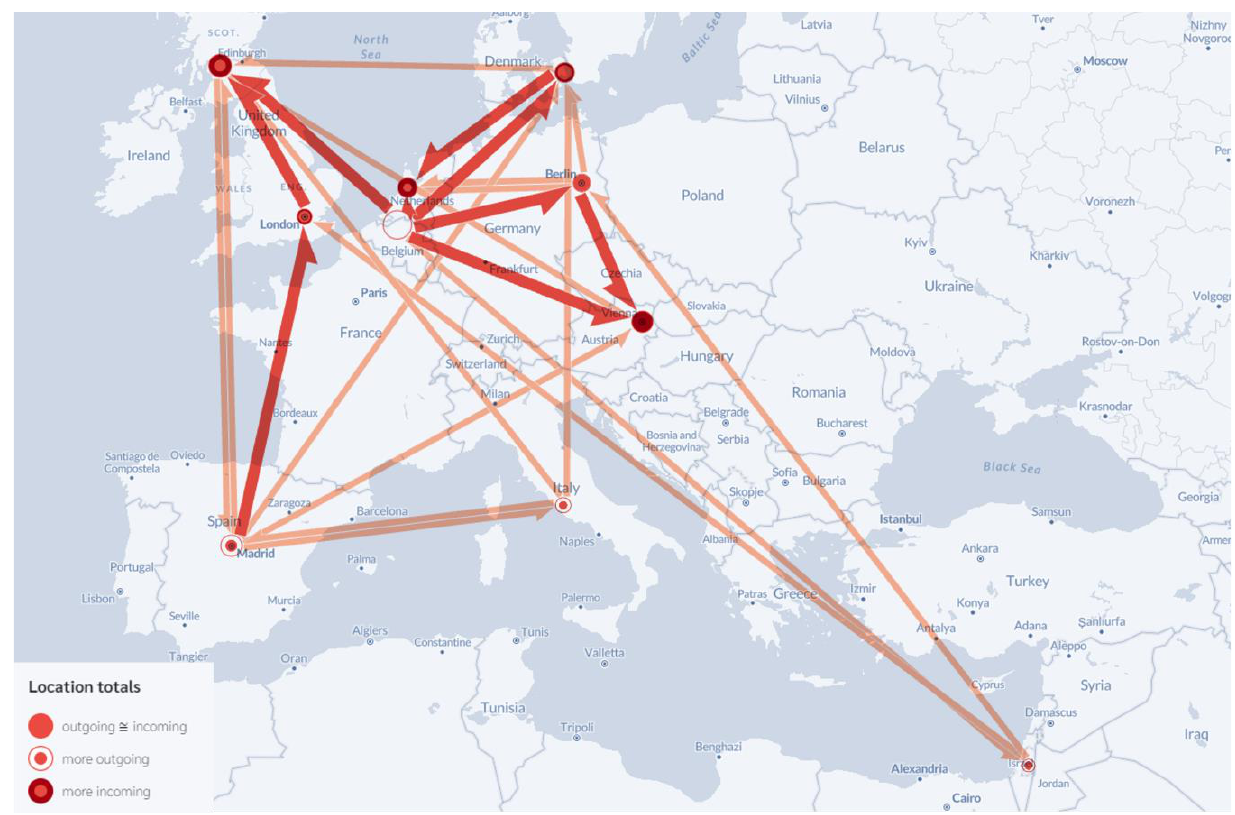
Figure 1. Significant early dispersal pathways of the SARS-CoV-2 BA.4 subvariant across Europe. The red lines indicate the most significant viral migration events ( p - values ≤ 5.00 × 10 − 50 ); the direction of each arrow documents the destination. Dots represent capital cities and not the place of residence of infected individuals. The color of each dot indicates the relationship between the points at the beginning and end of each arrow, including nearly equal ingoing and outgoing, more outgoing, or more incoming for each geographic locality. FlowmapBlue tool was used to visualize the data as a flow map (available online: https://flowmap.blue/; accessed on 6 October 2022).